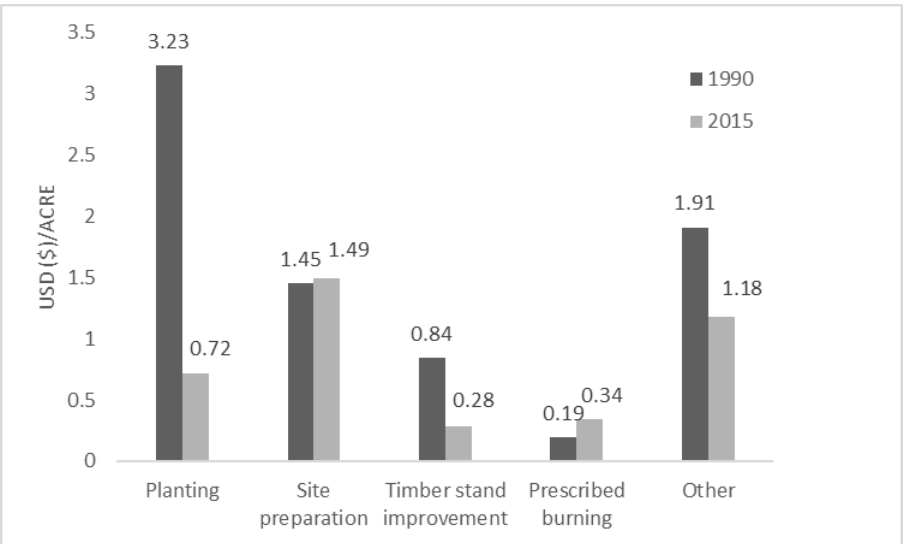
Figure 5. Mean expenditures for Timber Management Activities of the entire sample .